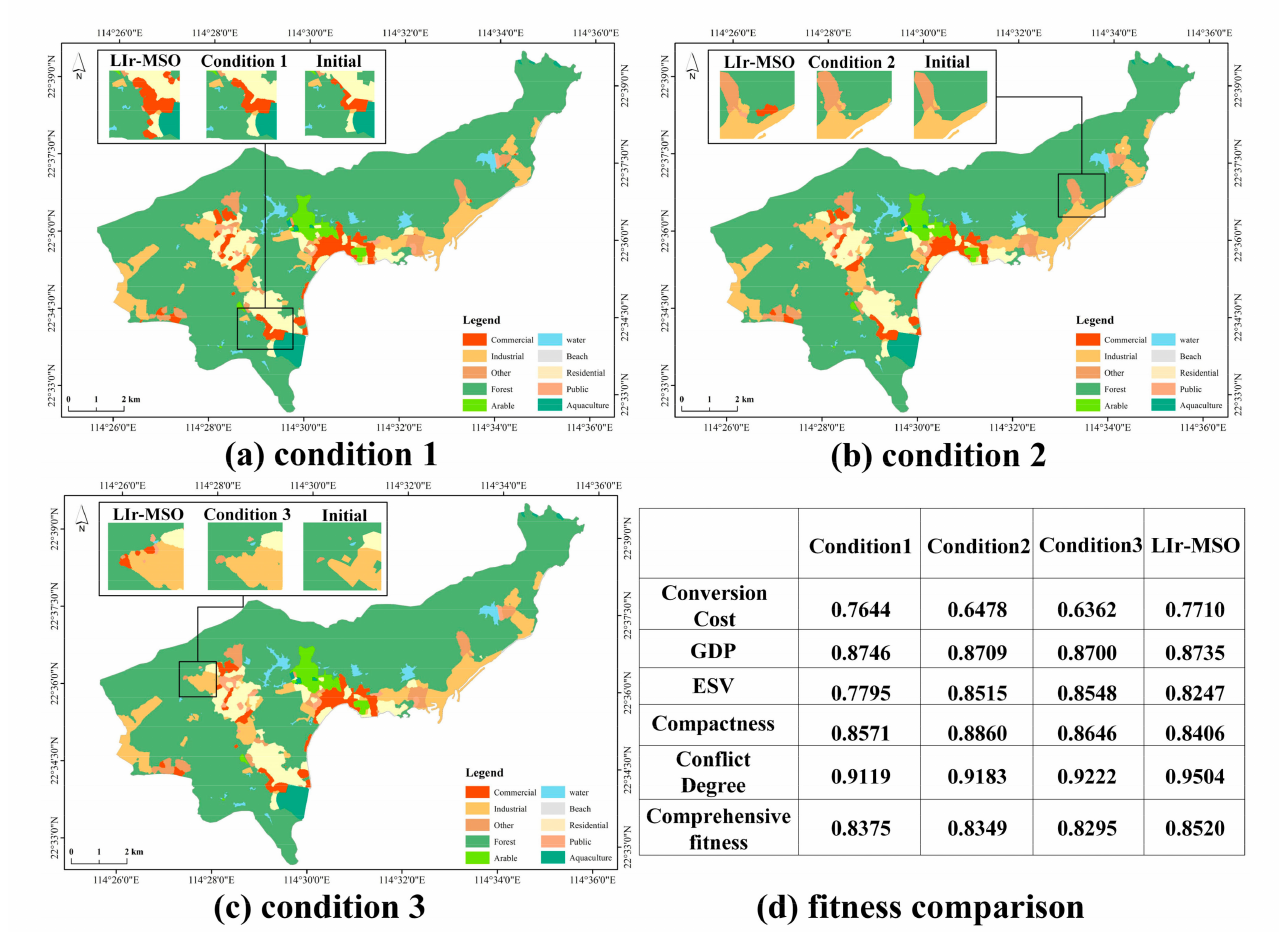
Figure 11. Comparison, including zoomed inserts, of final land-use patterns across three contrast experiments ( a – c ): 1. without initialization revision; 2. without mutation revision; 3. without initialization and mutation revision. In ( d ), the normalized values are listed for each experiment/condition and compared to the optimal solution obtained with the LIr-MSO